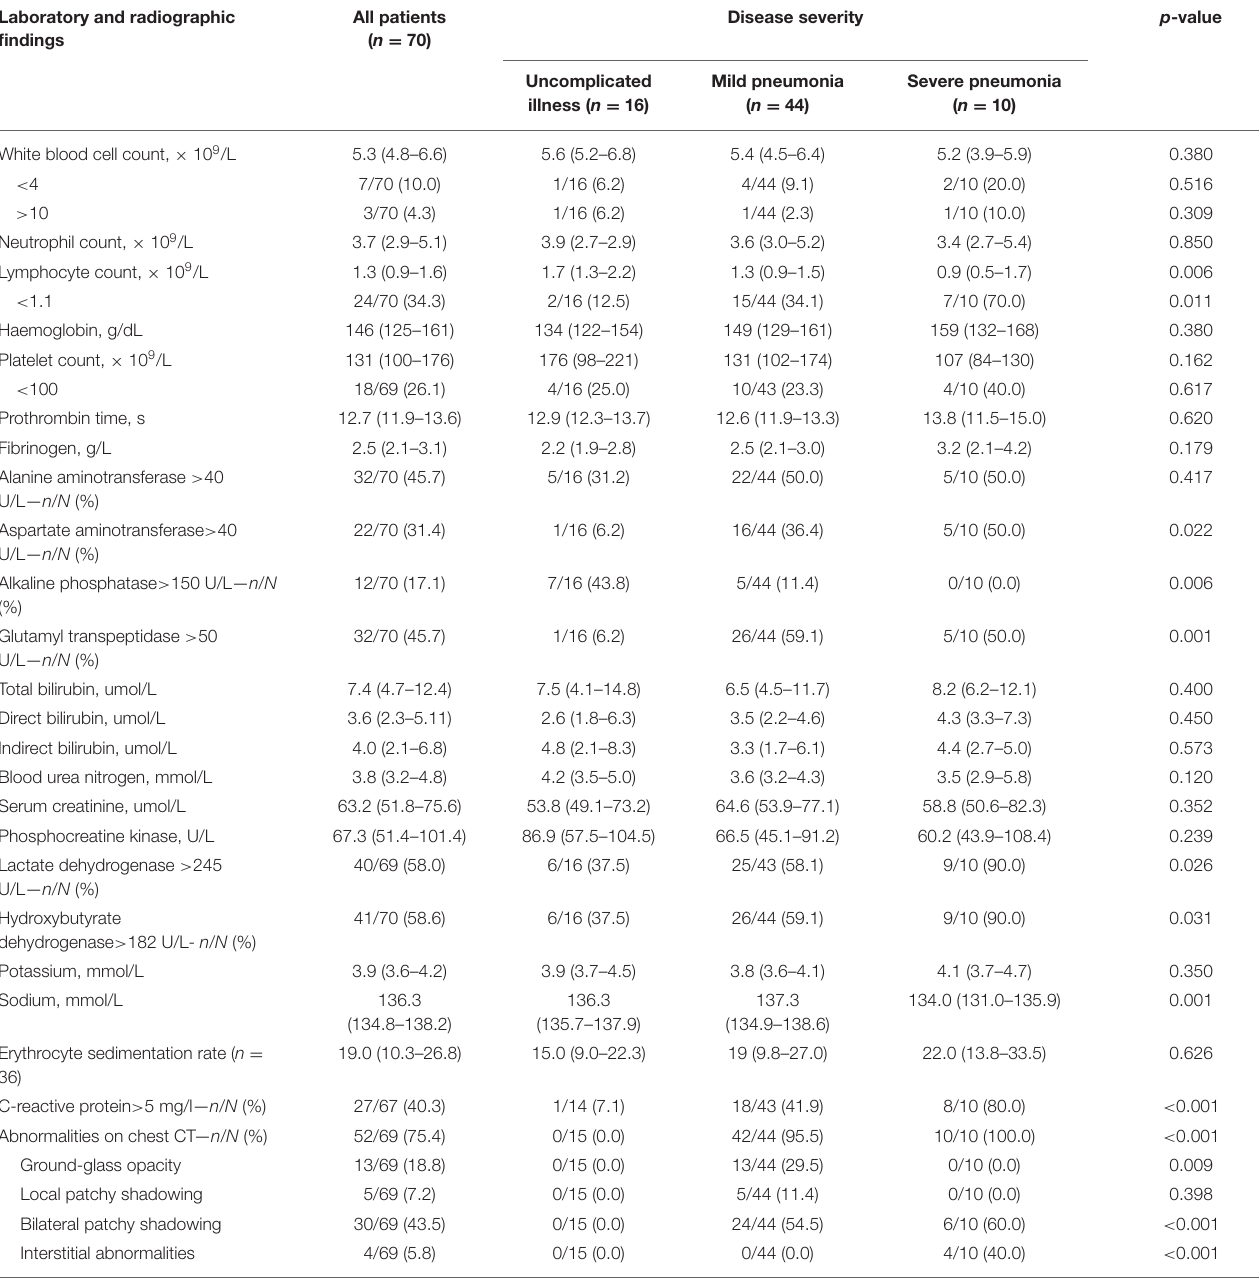
TABLE 3 | Laboratory and radiographic findings of 70 patients with COVID-19. Laboratory and radiographic